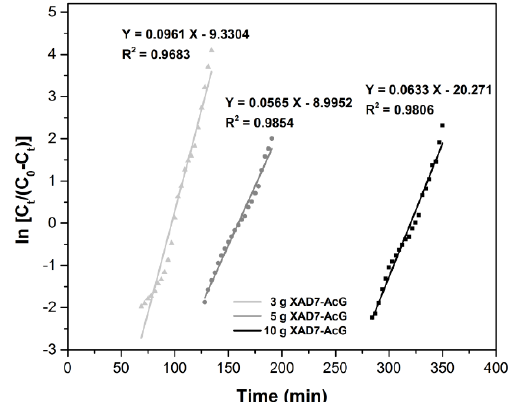
Figure 6. Yoon–Nelson plots for the adsorption of Au(III) in the fixed-bed column, at various amounts of adsorbent material.